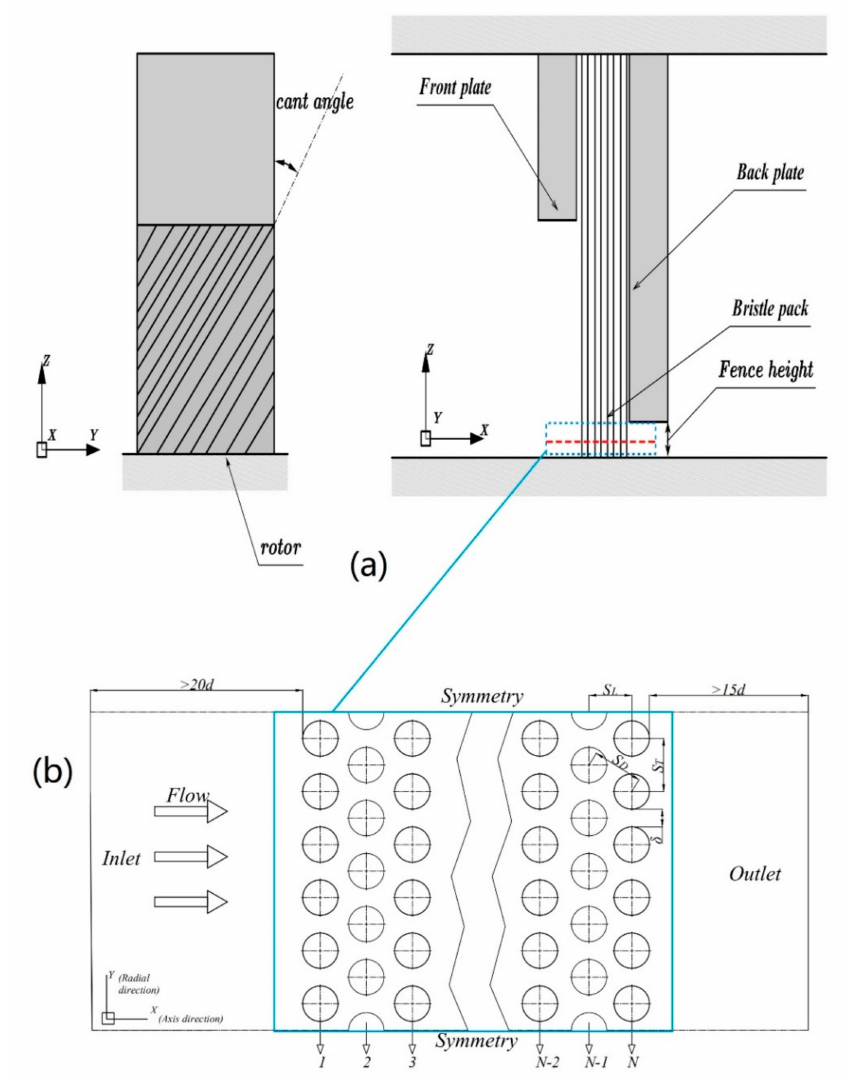
Figure 1. Schematic of a brush seal. ( a ) The structure of a brush seal; ( b ) the 2-D staggered tube banks